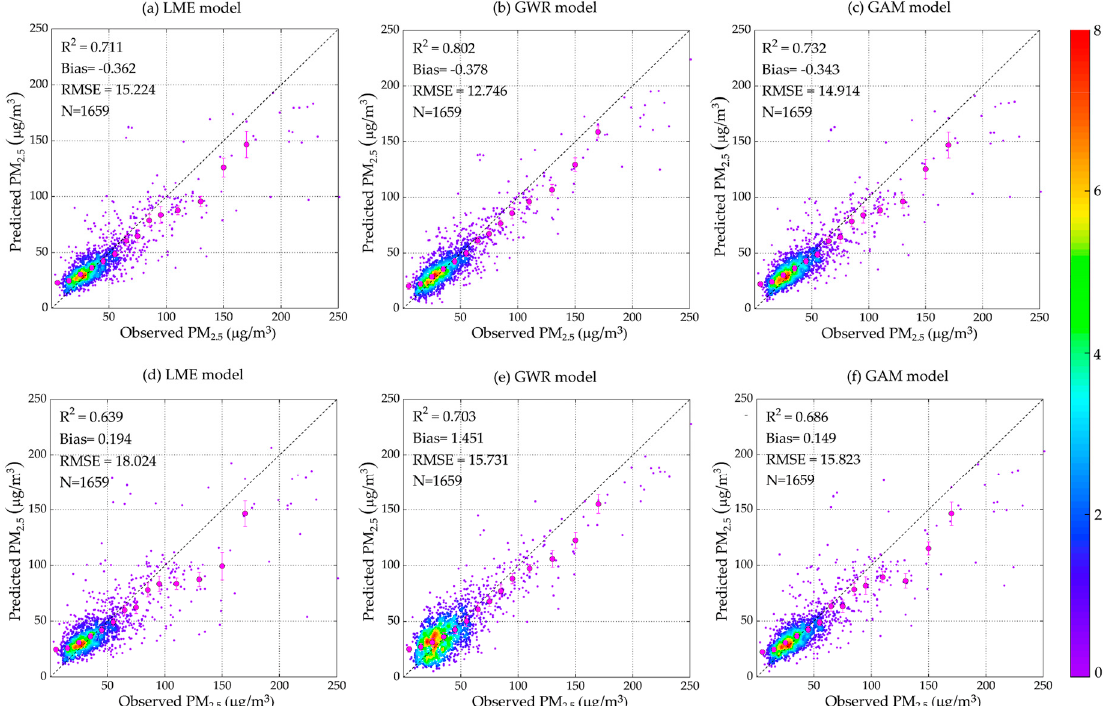
Figure 4. Results of predicted PM 2.5 (dry mass concentration of particles with an in situ aerodynamic diameter smaller than 2.5 µm) vs. observed PM 2.5 for model fitting (a – c) and cross-validation (d–f) . For details on the 10-fold cross validation method, see Section 2.4. The filled circles are the averaged predicted PM 2.5 binned in 10 µg/m 3 observed PM 2.5 intervals (20 µg/m 3 for observed PM 2.5 >100 µg/m 3 ), and the vertical lines on each circle represent error bars (the 1 σ SD of the fits). Statistics in the upper left corner indicate coefficient of determination ( R 2 ), bias (µg/m 3 ), root-mean-squared prediction error (RMSE, µg/m 3 ), and number of data points ( N ). The color bar on the right indicates the number of data points .